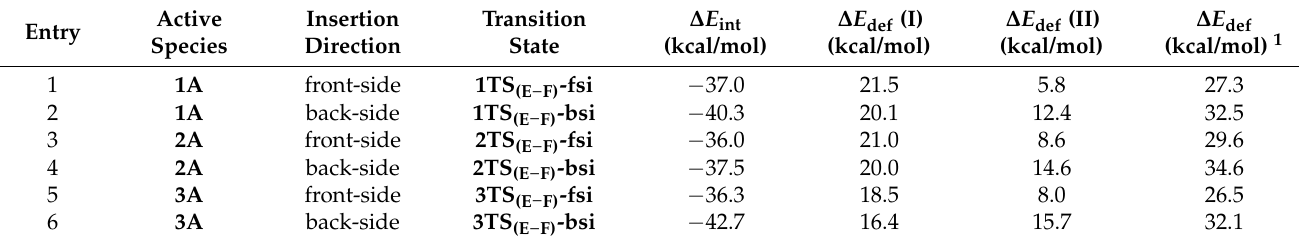
Table 1. The energy decomposition (kcal/mol) of six ethylene insertion transition states in chain propagation stage. Entry